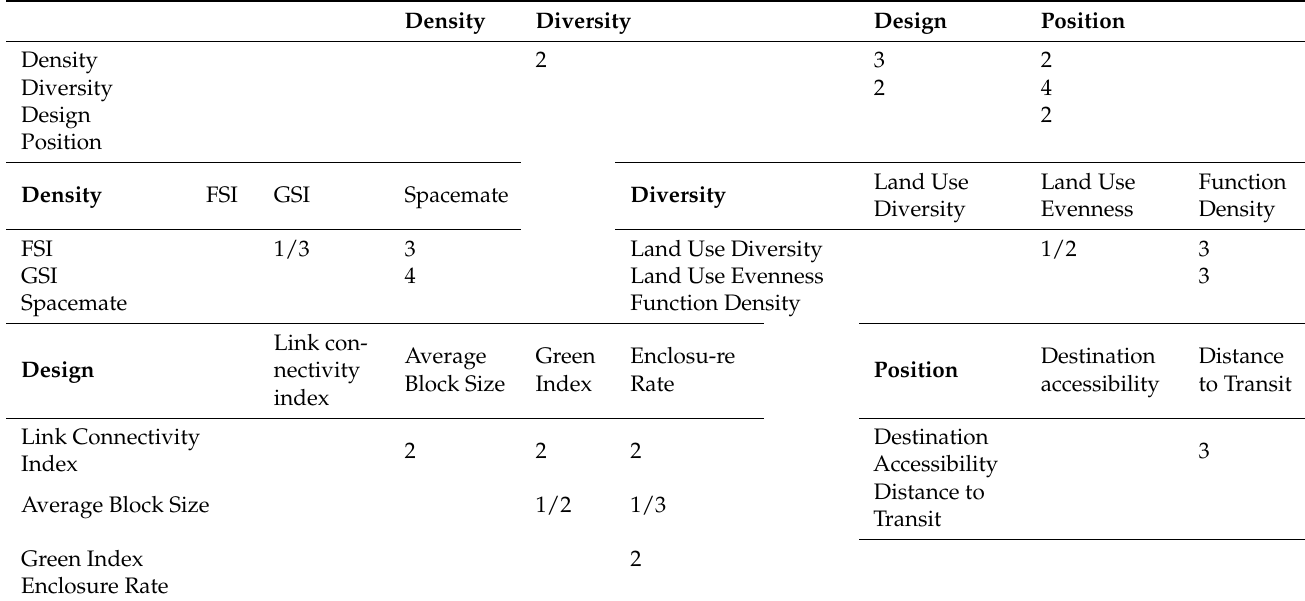
Table A4. Expert 4.